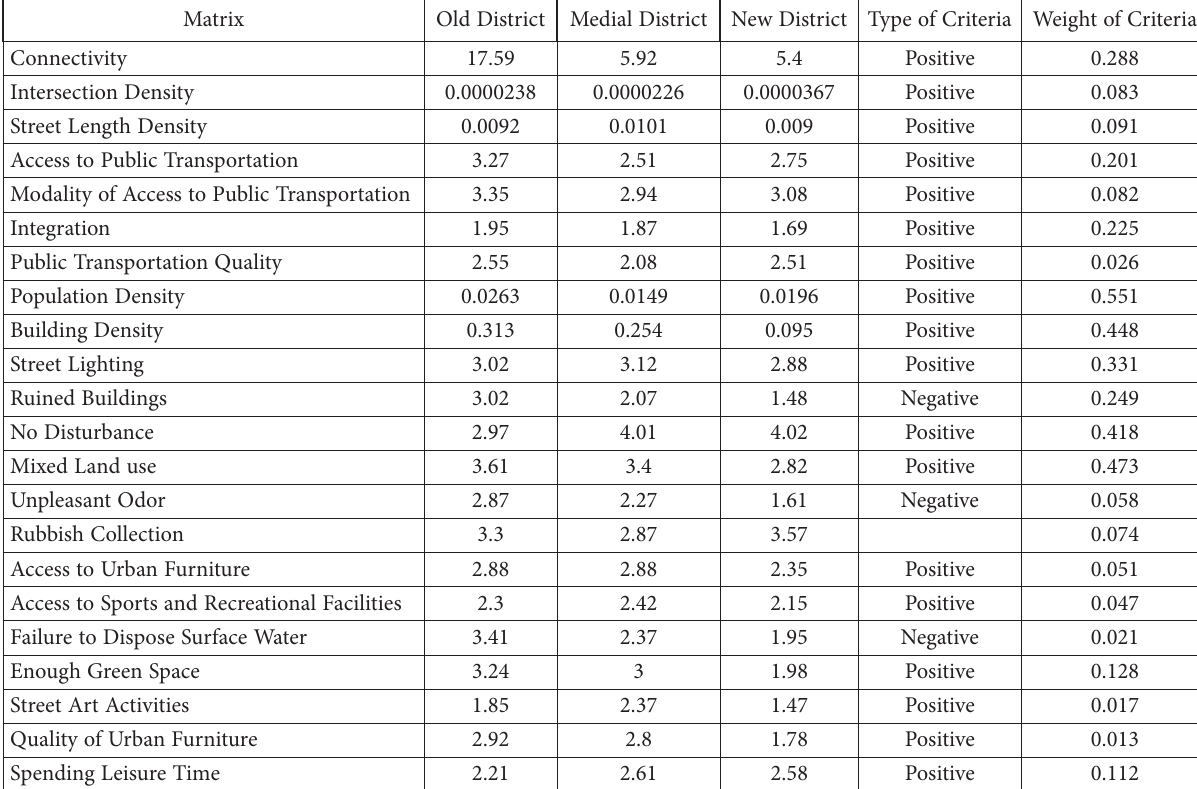
Table 8. Creating a decision matrix (source: